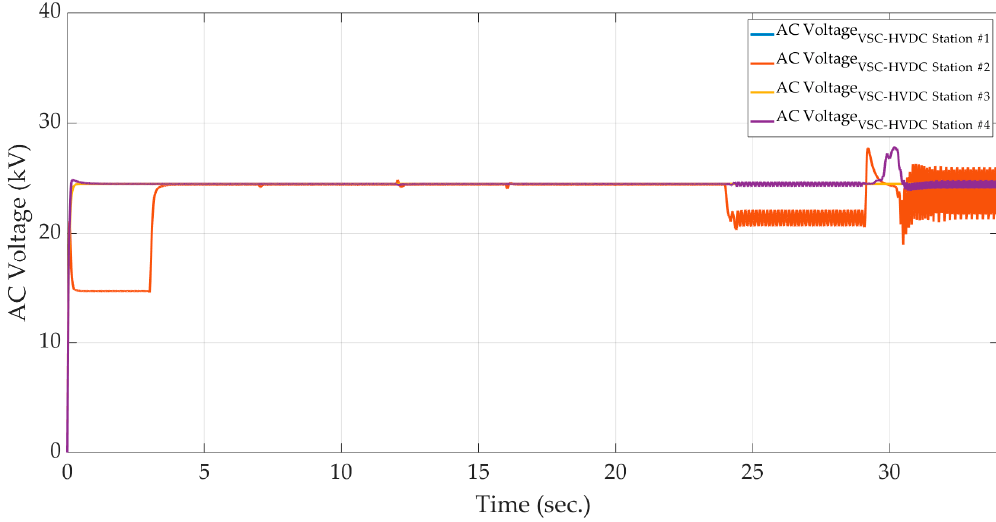
Figure 10. The AC voltage profile of different VSC-HVDC stations in the first scenario.